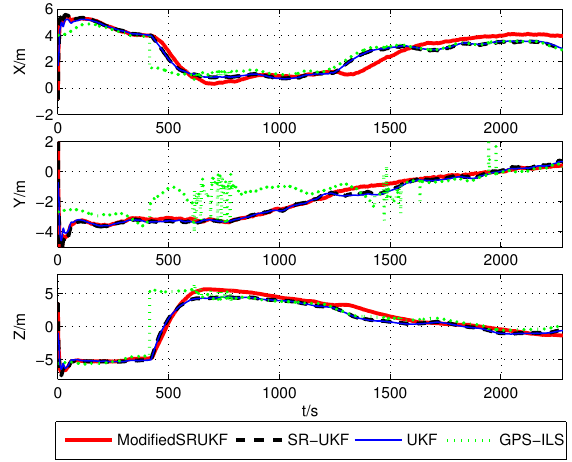
Figure 4. Position estimation error using GPS’s